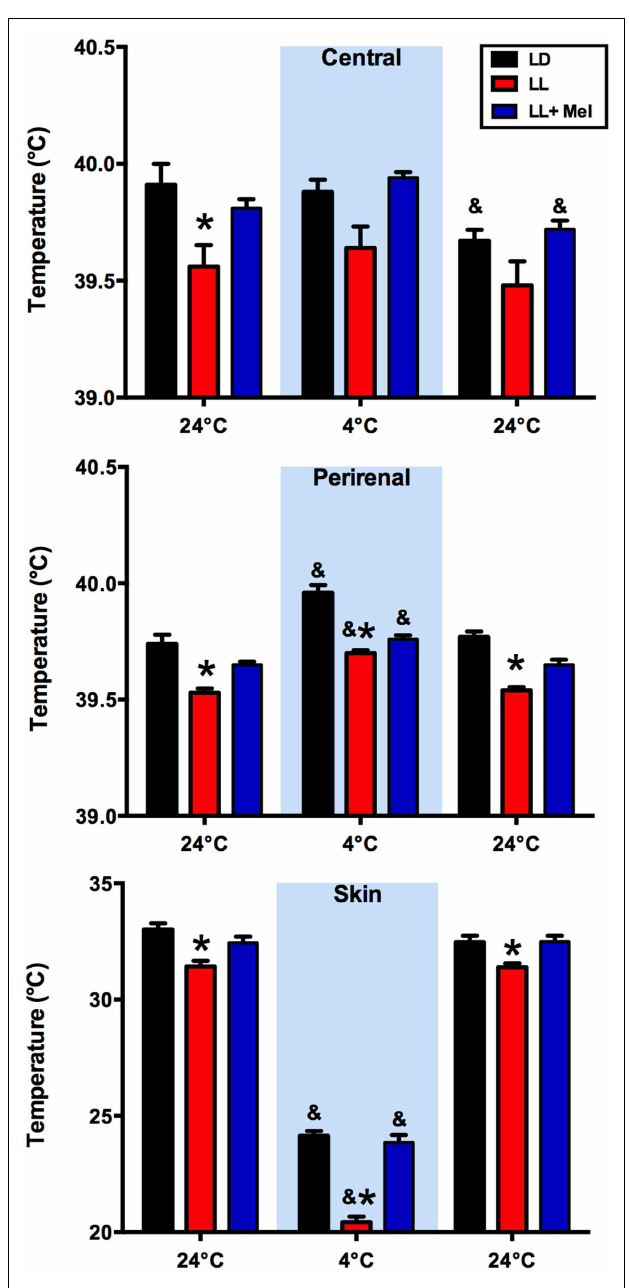
FIGURE 2 | Response of central, skin, and perirenal temperature to exposure to 4°C in 5days old lambs . Data are means ± SEM. LD, newborns gestated in ewes exposed to photoperiod 12:12; LL, newborns gestated in ewes kept in continuous light from 60% gestation to term and LL + Mel, newborns gestated in ewes kept in continuous light but receiving an oral dose of 12mg melatonin at 1700h. LD and LL n = 6. LL + Mel n = 4. * P < 0.05 vs. LD; & P < 0.05 vs. first values at 24°C.ANOVA andTukey’s